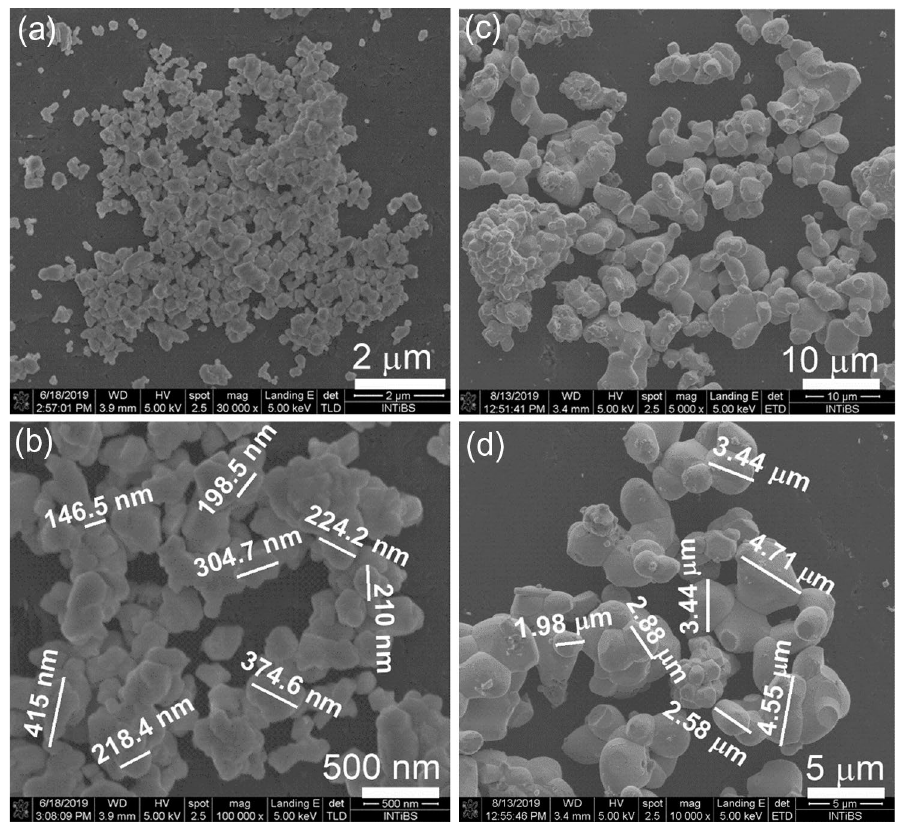
Figure 1. SEM images of BMW: 5% Eu 3+ synthesized by CP ( a , b ) and MC method ( c , d